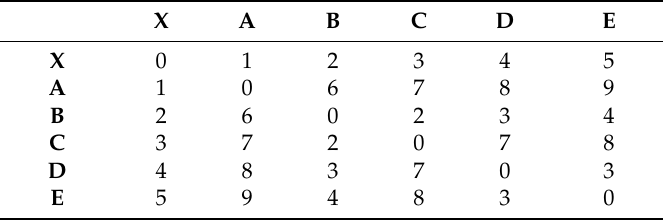
Table 4. Symmetric Cost Matrix for mTSP with five cities.